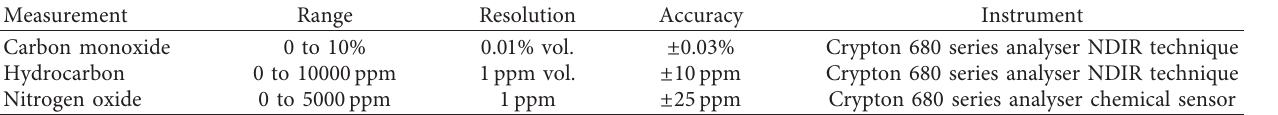
Table 3: Details of the emission analyser.